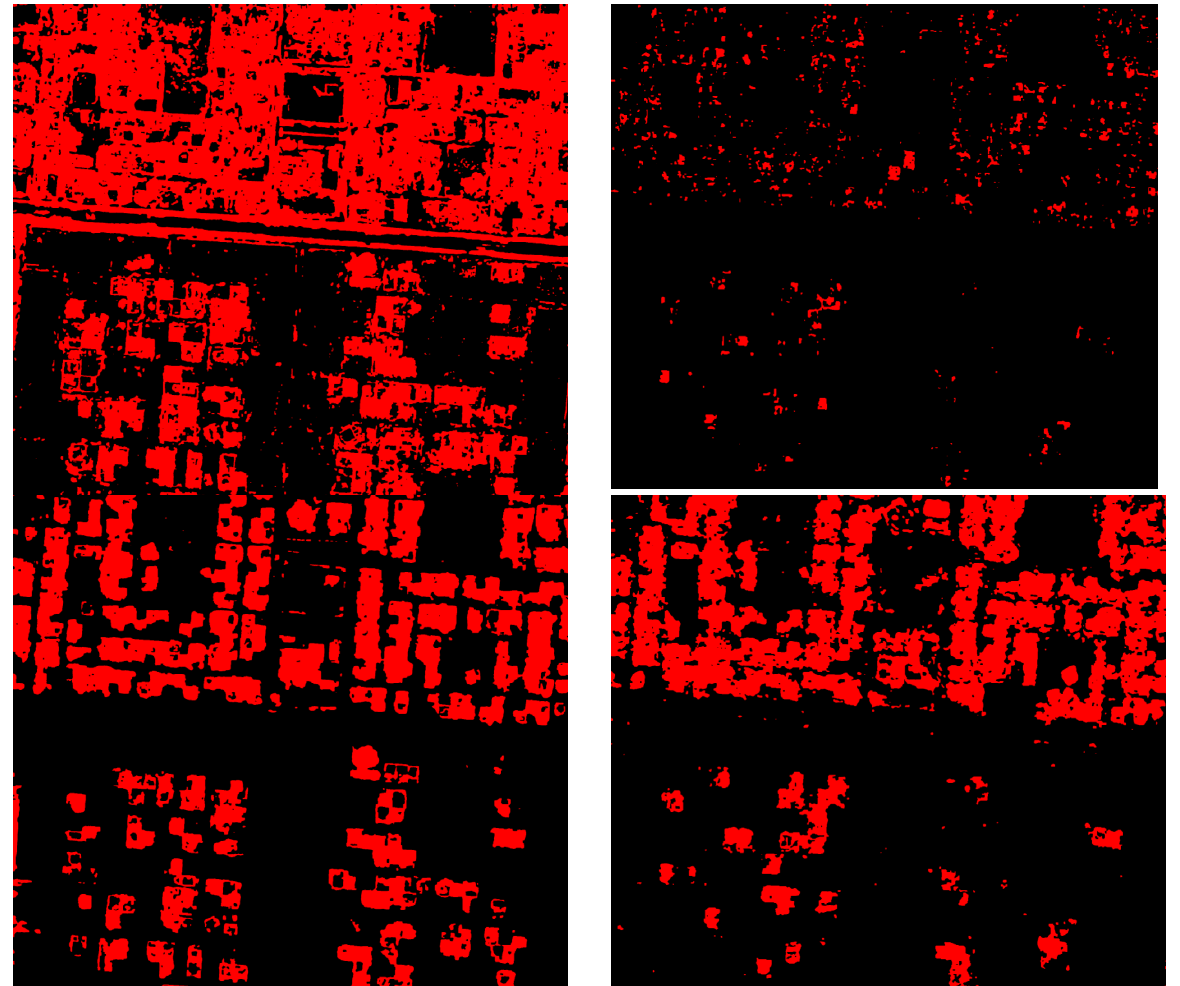
Figure 9: Classification results for GeoEye (left) and Ikonos (right) images. Upper row: without nDSM value, lower row: including nDSM value.